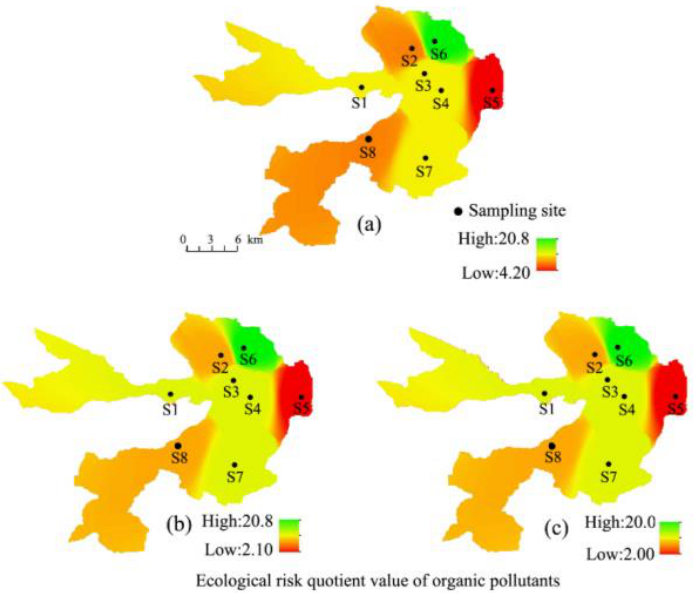
Figure 5. Risk quotient in the spring ( a ), summer ( b ), and autumn ( c